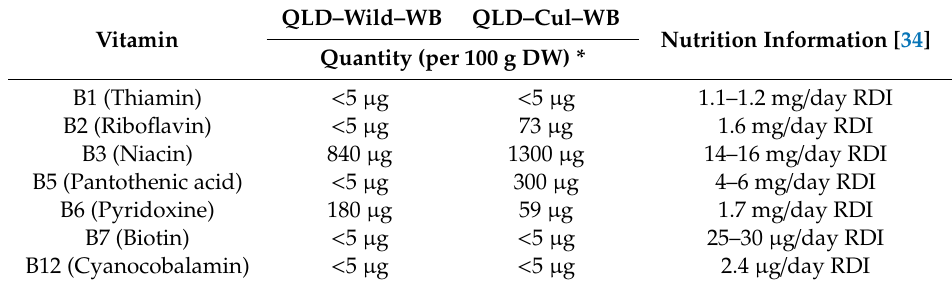
Table 3. Selected B vitamins in P. angustifolium whole branch samples collected in Queensland.